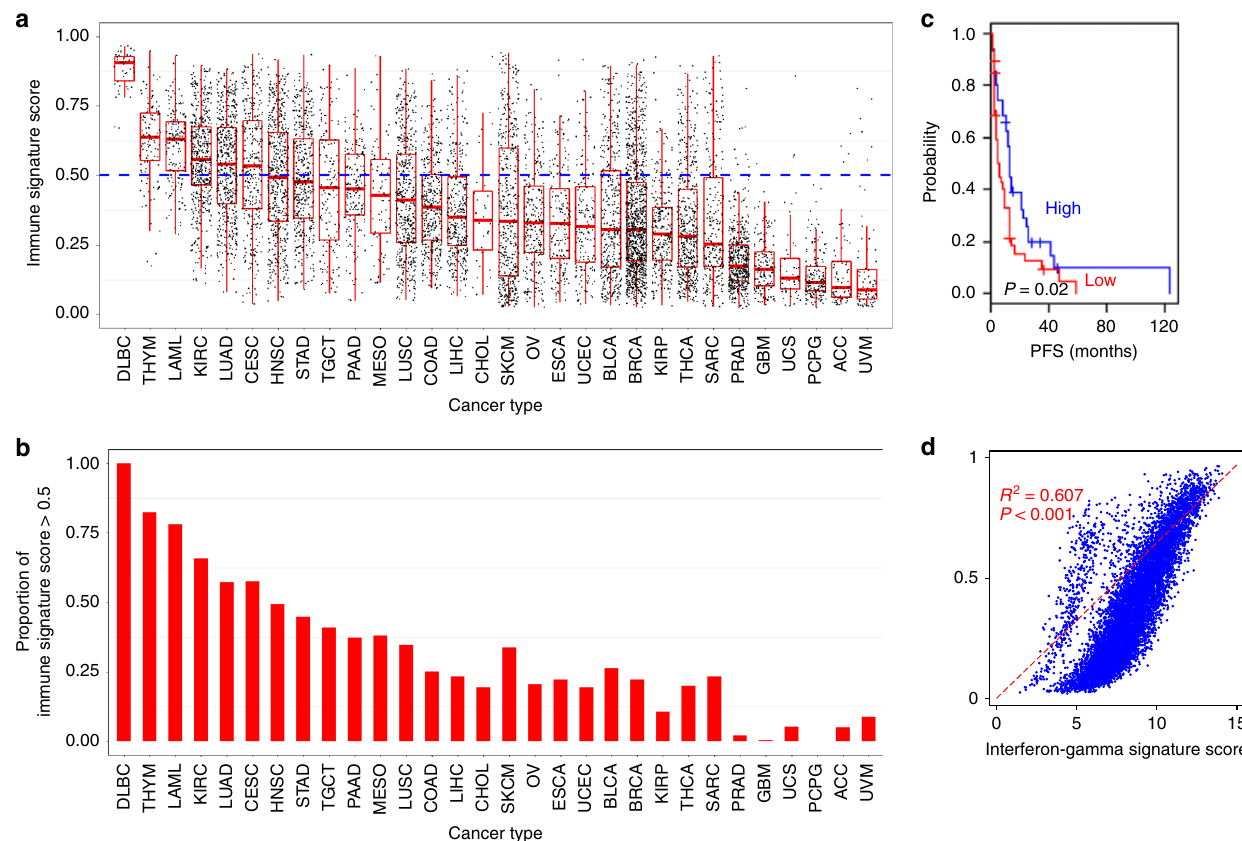
Fig. 2 Immune signature scores and potential responders to immunotherapy across major cancer types. a Immune signature (IS) score calculated by Bayesian probability of immune signature is plotted according to cancer types. Each black dot represents IS score, and red lines in the box represent upper 75%, median, and lower 25% values of each cancer type. Blue line represents IS score of 0.5. b Proportion of potential responders to immunotherapy (IS score > 0.5) is shown according to cancer types. c Kaplan − Meier plots of progression-free survival (PFS) of advanced melanoma patients in TCGA treated with immunotherapy. Of 472 patients with melanoma, only 78 patients treated with immunotherapy were included in analysis. Patients were strati fi ed according to IS scores (high > 0.5). d Association between IS score and interferon-gamma signature score. Scatter plot and fi tted dash line showed the signi fi cant association between IS score and interferon-gamma signature score. Abbreviation of cancer type was referred from The Cancer Genome Atlas tag. See also Supplementary Figs. 8 − 11 and Supplementary Data 3,